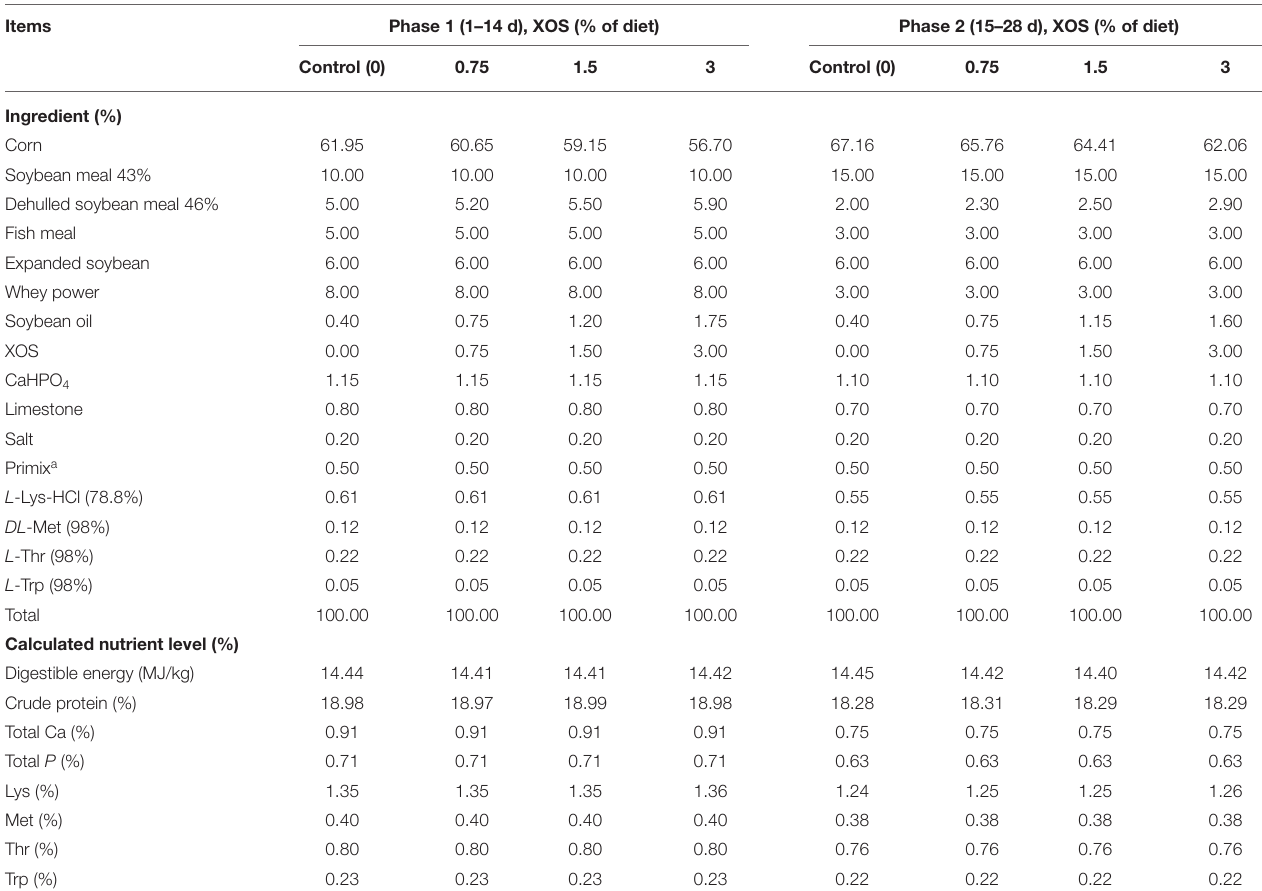
TABLE 1 | Composition of the experimental diets (as-fed